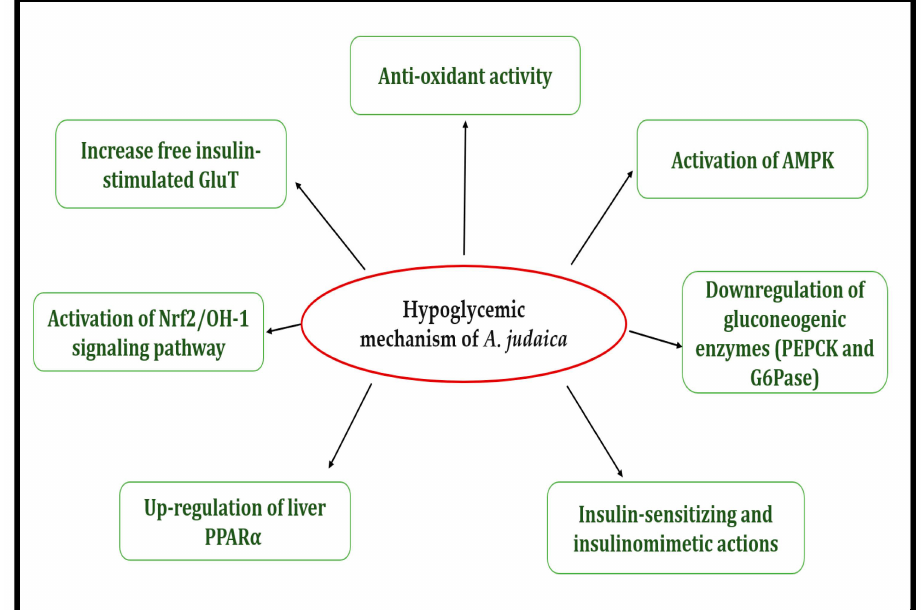
Figure 6. Different mechanisms of action of the antidiabetic effects of Artemisia